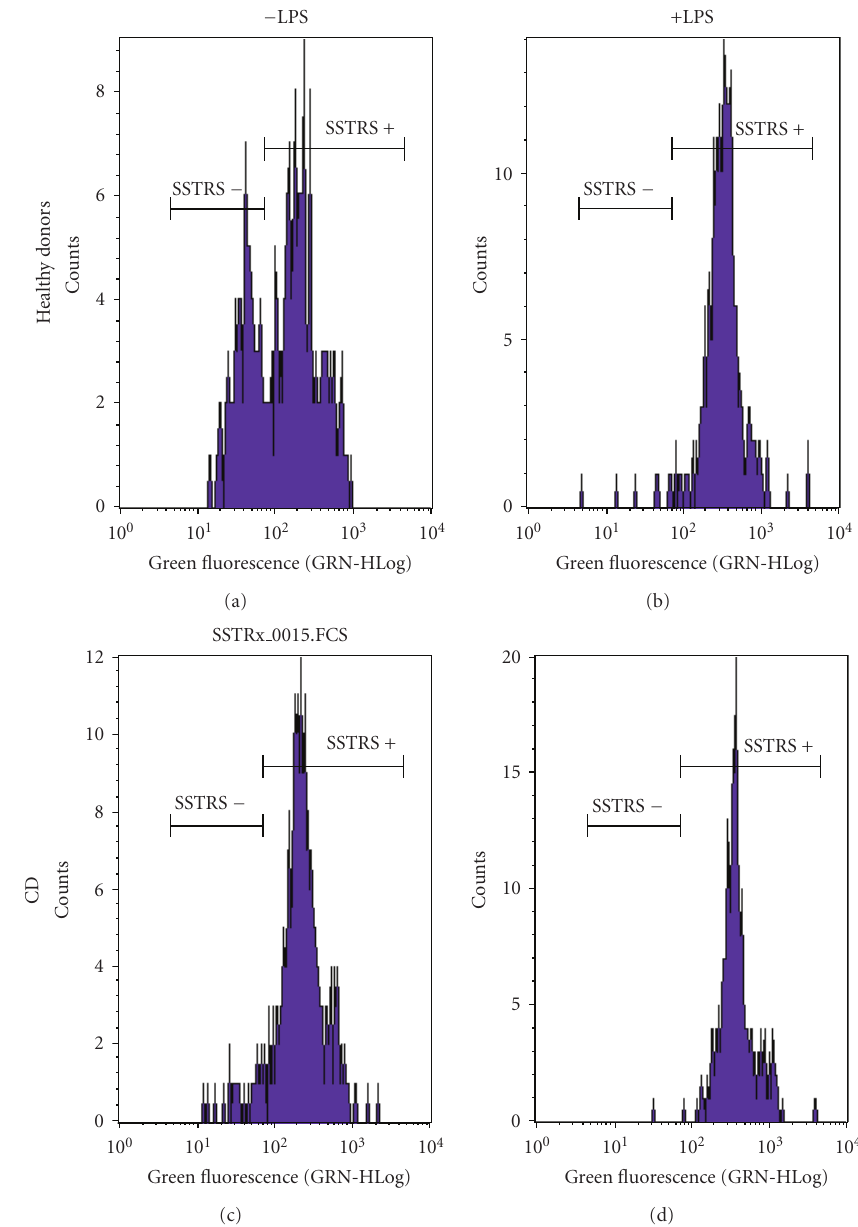
Figure 1: SSTR5 protein expression in PBMCs of CD patients and healthy donors activated or not by LPS. To mimic inflammation, PBMCs were incubated in presence or absence of LPS (1 μ g/mL) for 2 hours 30 minutes at 37 ◦ C. The cells were fixed and permeabilized and SSTR5 revealed by an Alexa 488 coupled antibody. The histogram (b) shows that after LPS activation of healthy PBMCs, all cells were presenting SSTR5 proteins, in the same way that PBMCs from CD patients activated (d) or not (c) by